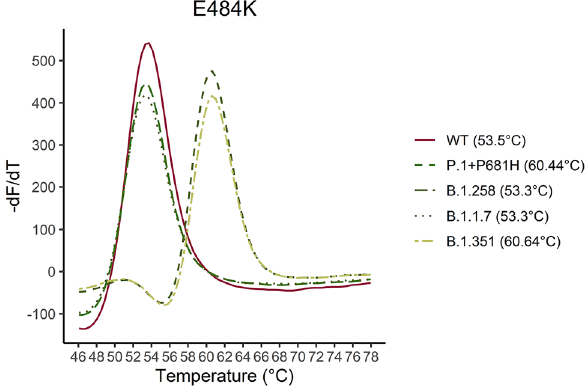
Figure 6. Five samples for the P.1 + P681H, B.1.351, B.1.1.7, B.1.258 and WT were analyzed. The melting curve of the five samples are illustrated for the E484K assay. As it is shown in the graph the E484K mutation can be distinguished by approximately 7 °C from the WT sequence.